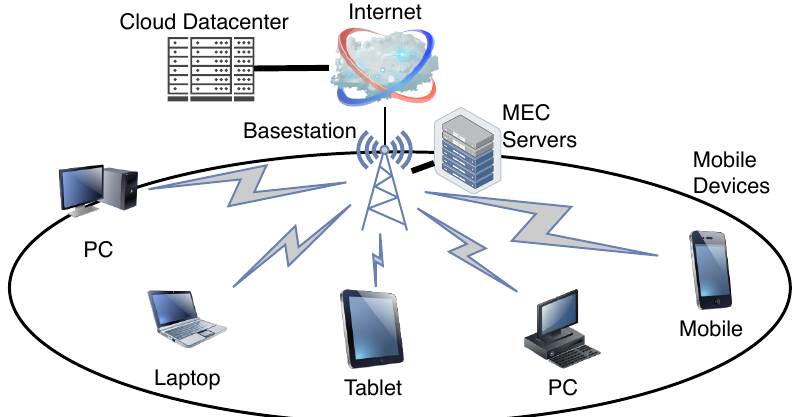
Figure 1. An illustration of mobile edge computing.